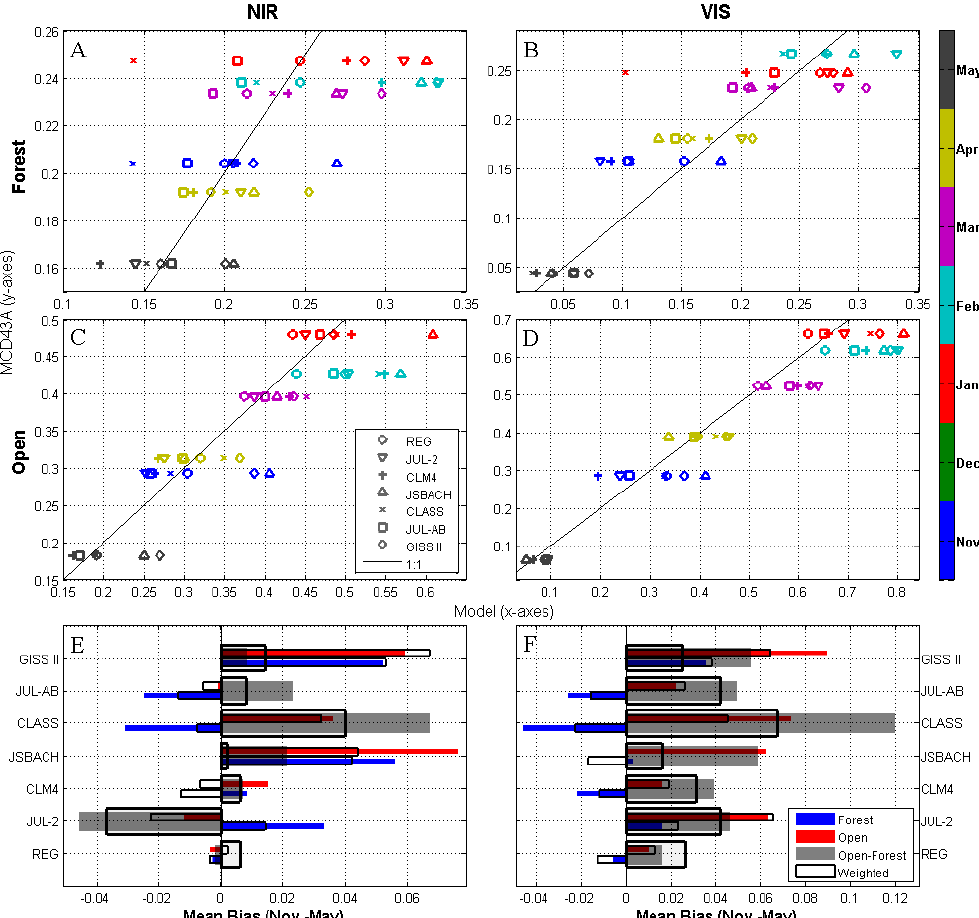
Figure 2. (a–d) Remotely sensed (MCD43A, y axes) and modeled ( x axes) direct-beam albedos (monthly means, 2007–2009) in evergreen needleleaf forests (a; b) and adjacent open areas (c; d) for both near-infrared and visible bands averaged across all three study regions; (e; f) : November–May mean bias (regional and monthly means, 2007–2009) and insolation-weighted mean bias. (a) , (c) , and (e) show the VIS band; (b) , (d) , and (f) show the NIR band. High solar zenith angles precluded the number of sufficient MODIS retrievals in December; thus December mean biases were excluded from the November–May mean; MB = 1